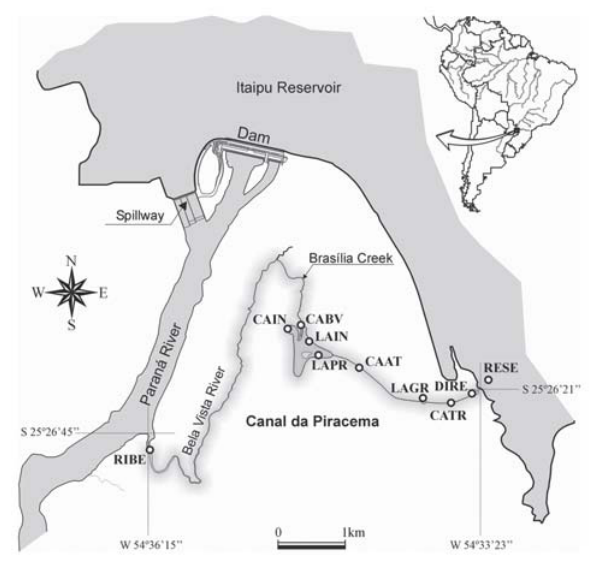
Fig. 1. Canal da Piracema and sampling stations, including the Paraná River.